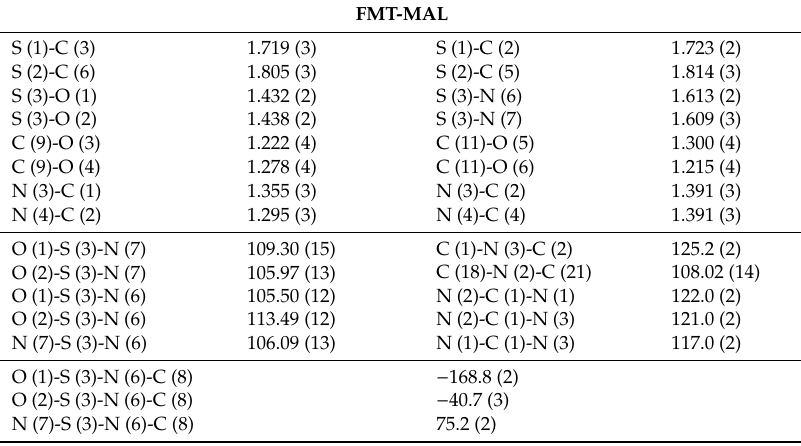
Table 2. Selected Bond Lengths (Å), Angles ( ◦ ), and Torsion angles ( ◦